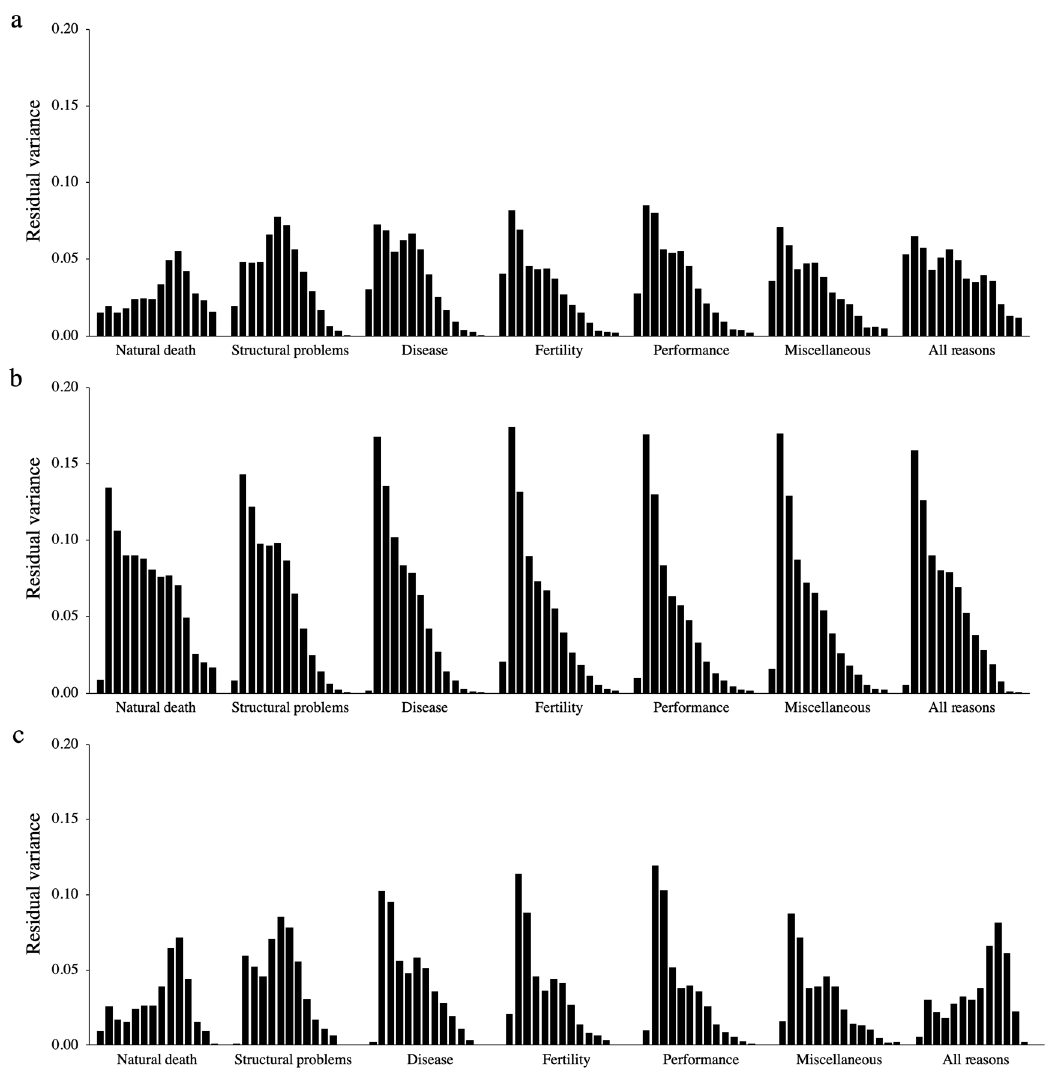
Figure 2. Residual variance estimated across different ages (from 2 to 15 years), considering all groups of culling reason (i.e., natural death, structural problems, disease, fertility, performance, miscellaneous, and all culling reasons together) and longevity definitions. The longevity definitions are: ( a ) traditional longevity, ( b ) functional longevity assuming 0 after the cow was culled or if the cow did not record a calf at the specified age, and ( c ) functional longevity assuming 0 only after the cow was culled, and missing records when no information of calving was found at the specific age.